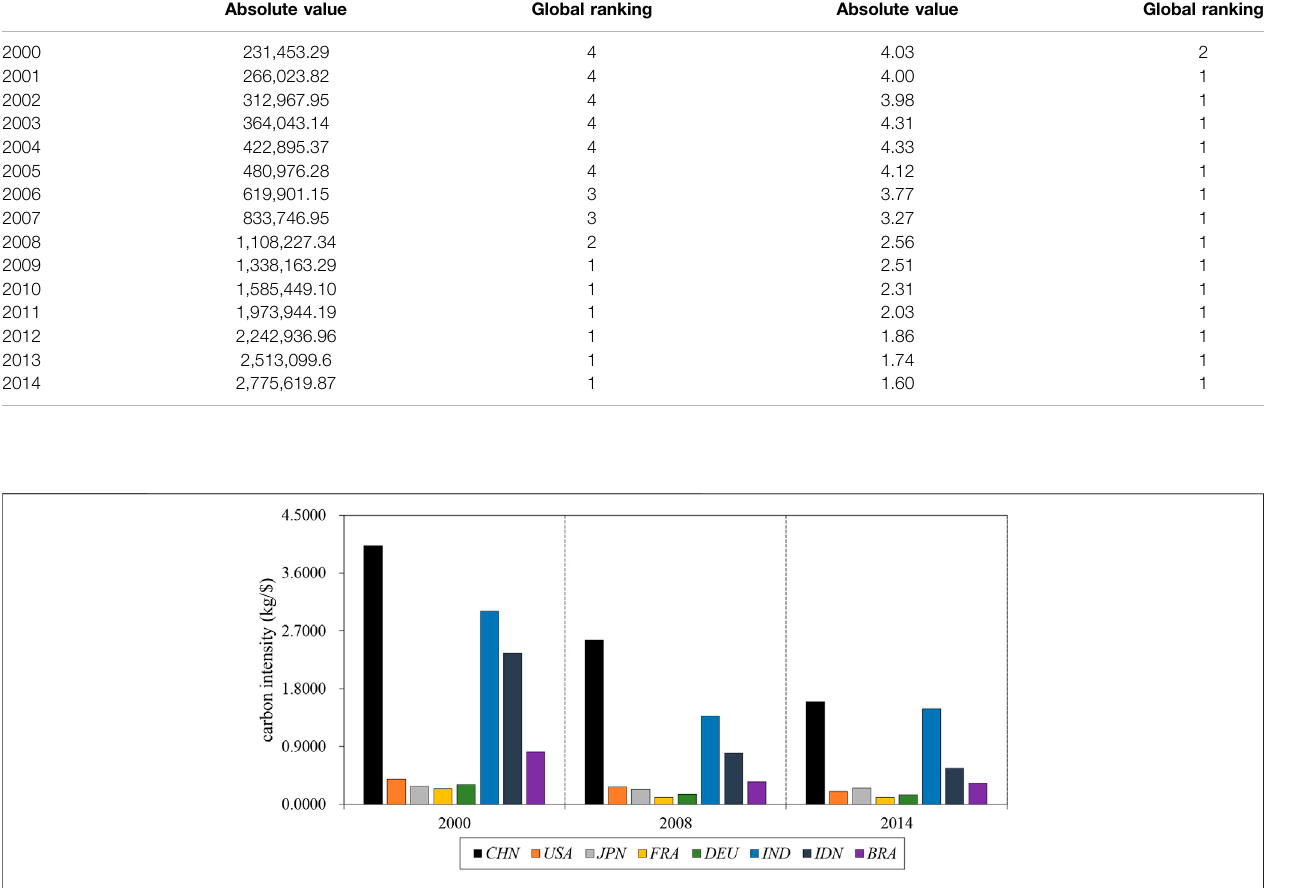
TABLE 2 | Final output and DCEI of China ’ s construction industry during 2000 – 2014. Final output (million dollars) DCEI (kilogram/dollar) Absolute value Global ranking Absolute value Global ranking